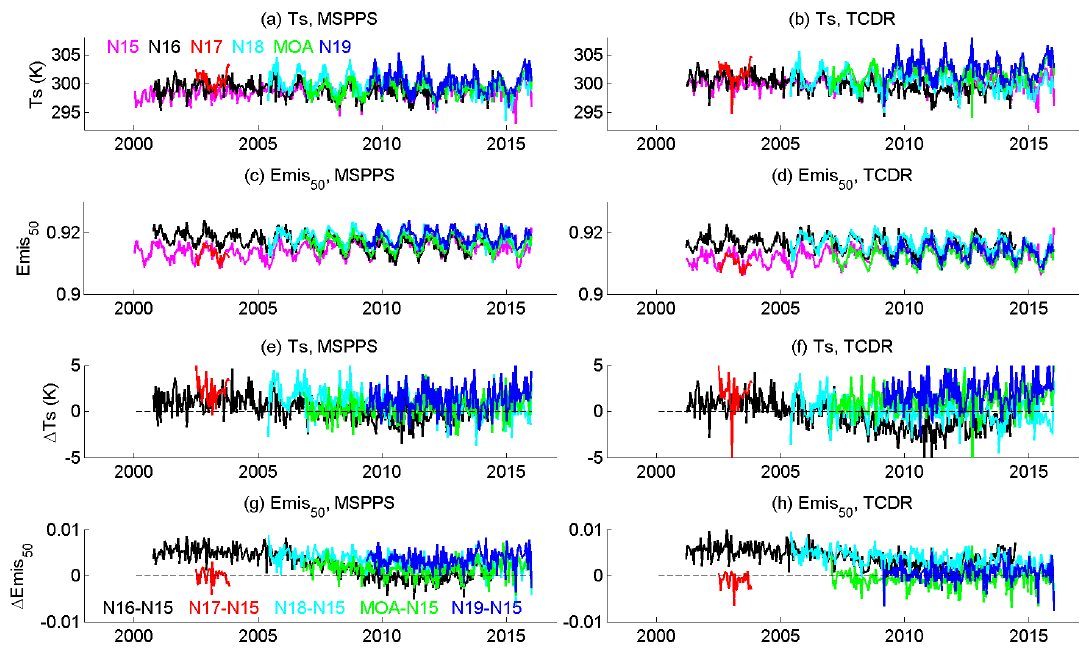
Figure 12. Retrieved tropical land products comparison, note di ff erent variables are used in di ff erent panels. Left panels display the products produced by MSPPS from 1b before inter-satellite calibration, while right panels are TCDR after inter-satellite calibration. Time series of land surface temperature (Ts) is shown in ( a , b ), the di ff erence versus N15 is shown in ( e , f ); time series of land surface emissivity of 50.3 GHz channel (Emis 50 ) is shown in ( c , d ), the di ff erence versus N15 is shown in ( g , h